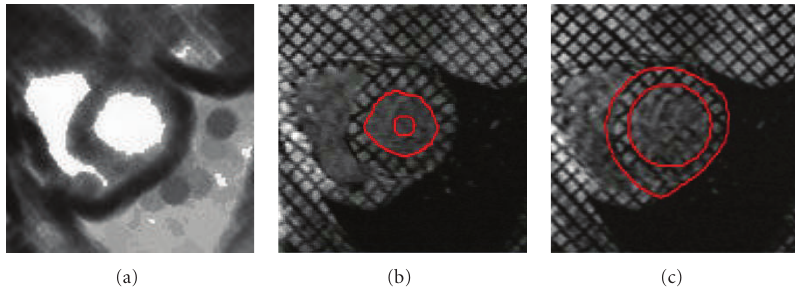
Figure 6: (a) Original image, (b) Computation of u epi map with N = 5, (c) ∇ u epi map .